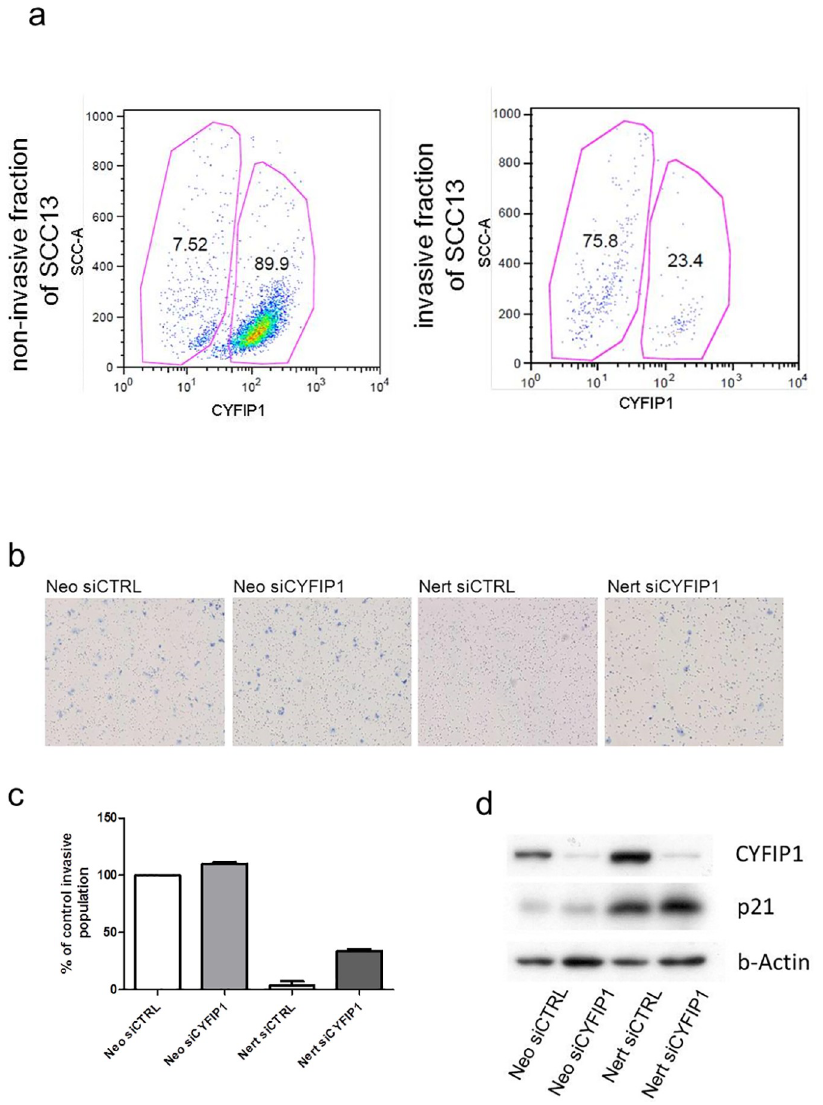
Fig 4. Notch1 inhibits cell invasion through CYFIP1. (a) SCC13 were starved for 2 days and then seeded in the matrigelcoated chamber, where the coated membranewith 8 um pores separated the cells from the medium full in supplements. The cells were then culturedfor 22 hours. After this timeframe the cells that migratedthrough the membranewere separatedfrom the remainingcells and thus dividedto invasiveand non-invasive fraction of SCC13 cells. The cells were next stained for CYFIP1 and analyzedby FACS. The invasivefraction of SCC13 cells shows a lower percentageof CYFIP1 positive cells as comparedto the non- invasivefraction (p < 0.001). (b) SCC13 cells were stably infected with a retroviral vector expressinga flag- taggedactivated Notch1 protein fused to the human estrogenreceptor (SCC13Nert), or empty vector control (SCC13Neo). The cells were subsequently treated with siRNA targeting CYFIP1 mRNA of unspecificcontrol. The cells were next kept in starving conditions, seededon the matrigelcoated membranewith 8 um pores and treated with Tamoxifen. After 22h hours of incubation the invasiveand non-invasive cells were countedand the invasioncapacity was calculatedas indicatedin the manufacturer protocol. Section (b) representsthe density of the invasive populationsin the end of the experiment. (c) SCC13 with activated Notch1 and treated with control siRNA (Nert siCtrl) showeddrasticallydecreasedinvasive capacity, which could be partially restoredwhen the Notch1 activated SCC13 cells were treated with CYFIP1 specific siRNA (Nert siCYFIP1). (d) For control, the cells were parallelanalyzedfor CYFIP1 and p21 expression.